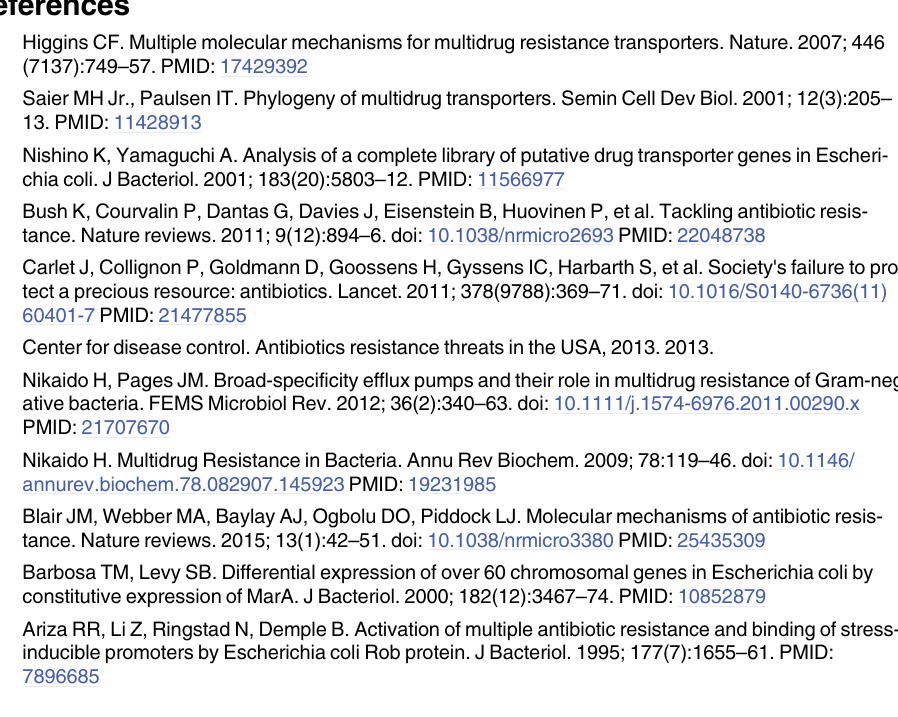
erythromycin and chloramphenicol were determined for the naïve and evolved states and the nil triple mutant of the WT-EV18.